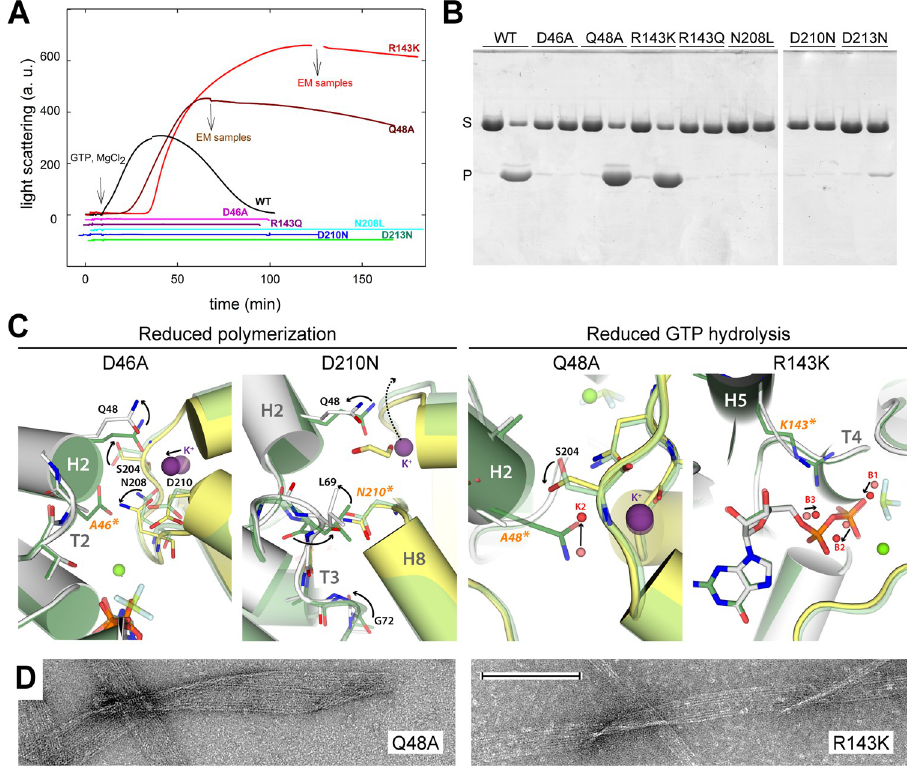
Fig 5. Functional and structural analysis of SaFtsZ mutants at the assembly interface. (A) Light scattering time courses during assembly of wild-type (black line), D46A, Q48A, R143Q, R143K, N208L, D210N, and D213N (color lines) SaFtsZ (50 μ M) to which 1 mM GTP was added and assembly triggered by addition of 10 mM MgCl 2 at time 0. Experiments were made as in Fig 1B. Flat scattering traces are offsetted to avoid superposition. Numerical data for each curve can be found in S2 Data. (B) Sedimentation assays of polymer formation by wild-type and mutant SaFtsZ (31 μ M) with 10 mM MgCl 2 by high-speed centrifugation at the time of maximal scattering. For each sample, the left and right lanes contain 1 mM GDP and GTP, respectively; pellet (“P” label) and supernatant (“S” label) samples were consecutively loaded with a 15-min time shift in SDS-PAGE. (C) Superposition of SaFtsZ mutant structures in complex with GDP (gray and yellow for bottom and top monomers, red spheres for water) onto that of the wild-type protein in complex with GDP, BeF 3 − , and Mg 2+ (dark green and light green for bottom and top monomers, salmon spheres for water). Black arrows indicate conformational rearrangements between both structures. (D) Representative electron micrographs of polymers formed by Q48A and R143K. The bar indicates 200 nm. WT,